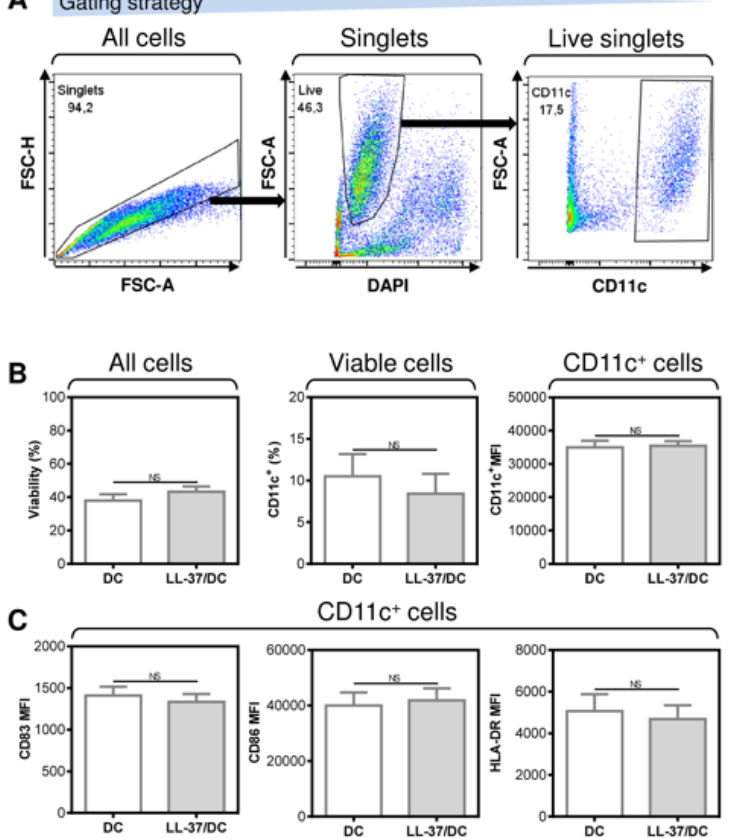
Figure 5. The application of LL-37 during DC production (differentiation, pulsation, and maturation) had no impact on DC viability, yield, or maturation. ( A ) The gating strategy used to analyze flow cytometry data. ( B ) The viability (left panel), DC frequency (CD11c + , middle panel), and their CD11c + staining intensities (right panel). ( C ) The staining intensities of the DC maturation markers CD83 (left panel), CD86 (middle panel), and HLA-DR (right panel). In ( B , C ), mean + SEM and significances of differences between the group of DC and LL-37/DC samples are indicated ( NS p > 0.05; n = five donors; paired two-tailed Student’s t